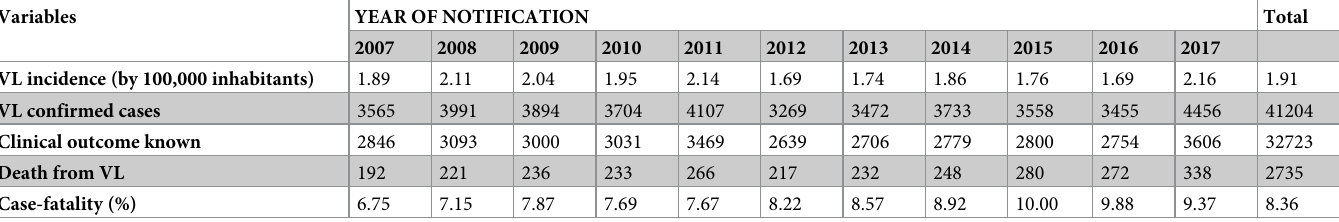
Table 3. Number of visceral leishmaniasis cases, deaths, incidence and case-fatality, Brazil, 2007–2017. Variables